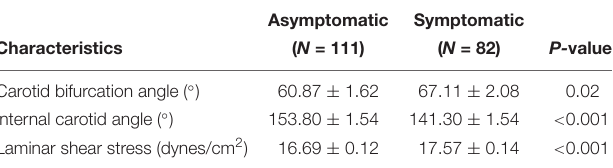
TABLE 2 | Comparison of carotid bifurcation, internal carotid angle, and laminar shear